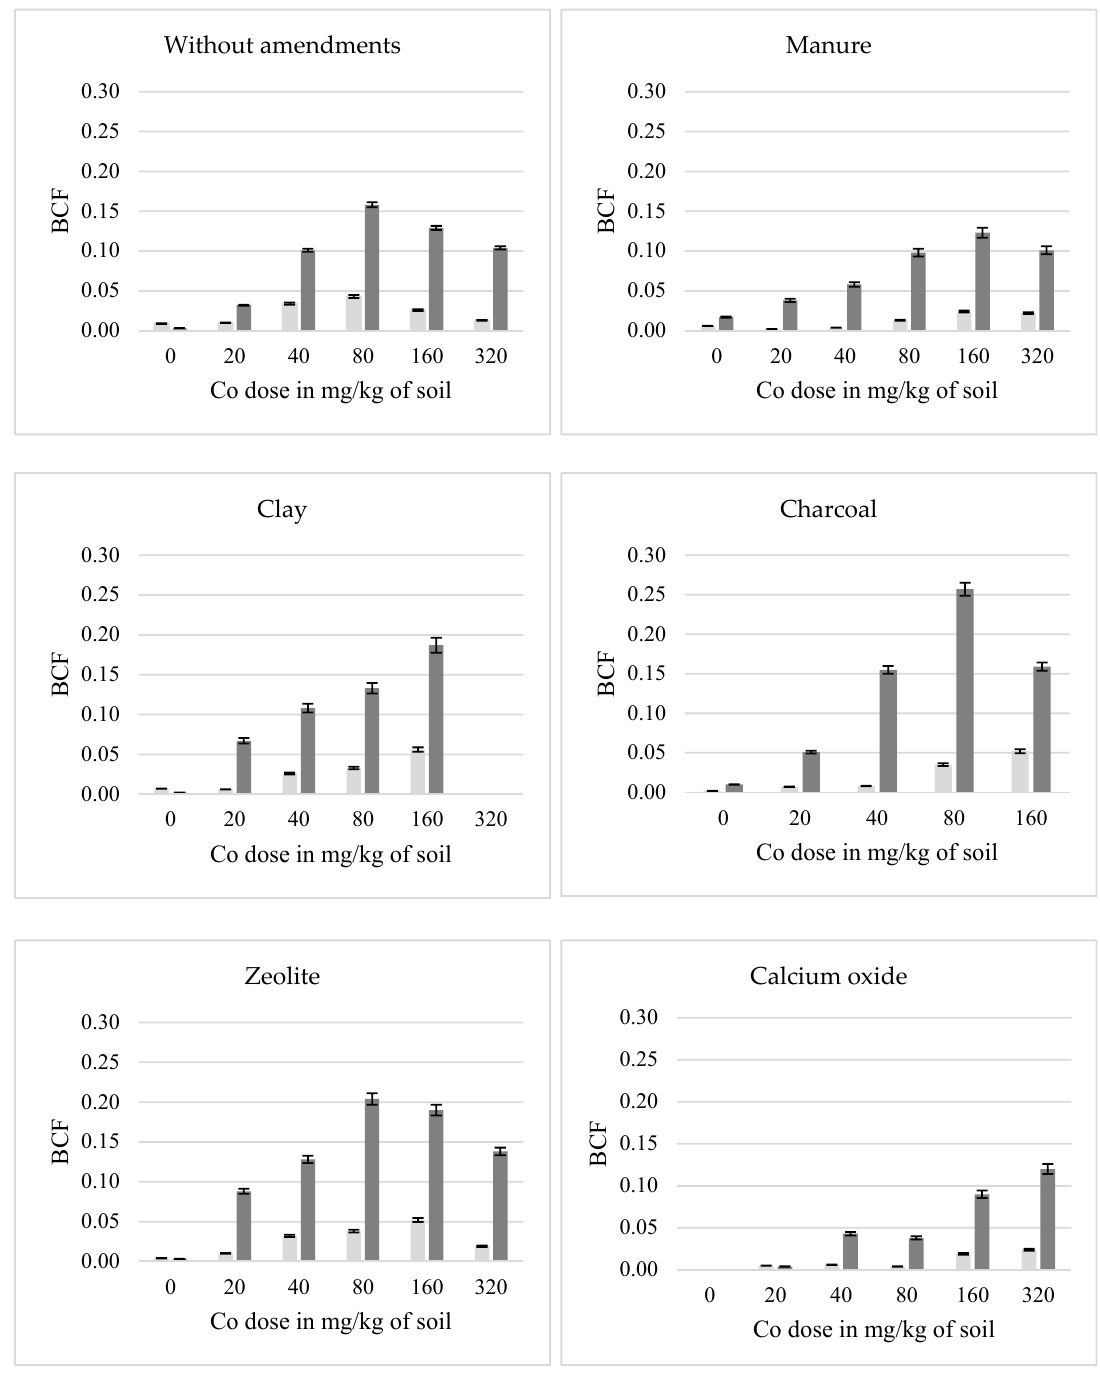
Figure 2. Bioconcentration factor (BCF) of cobalt in spring barley above-ground parts and roots.